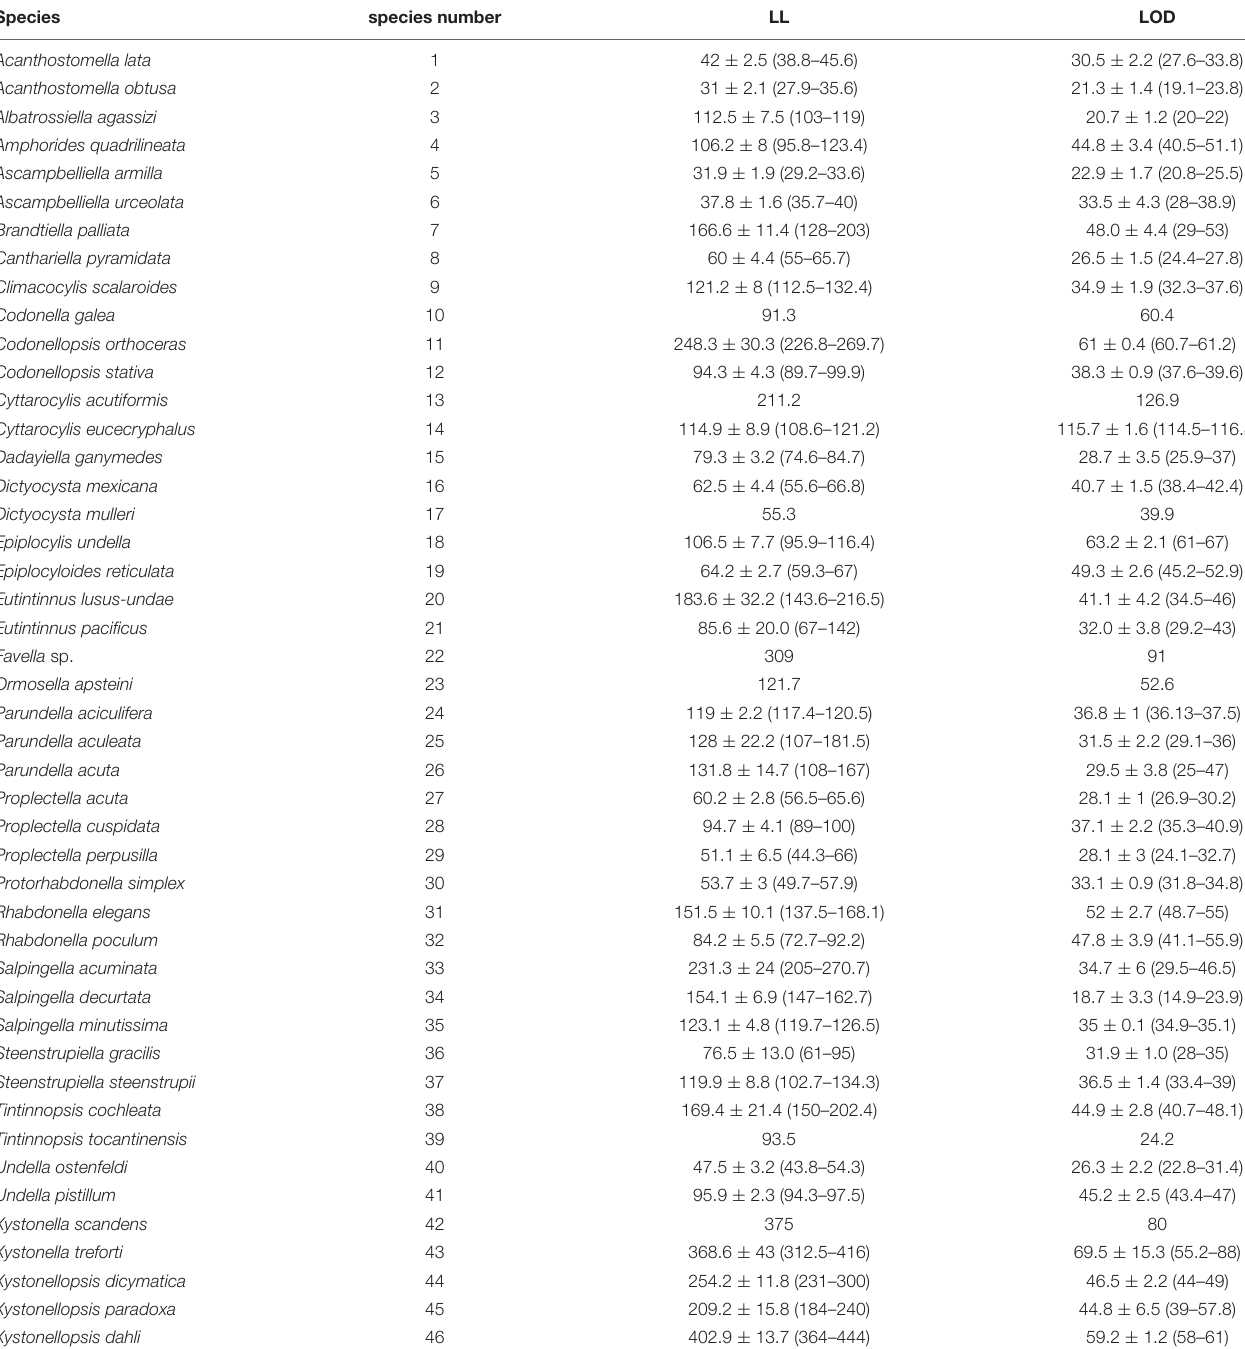
TABLE 1 | Tintinnid species list and measurement data including lorica length and lorica oral diameter. Species species